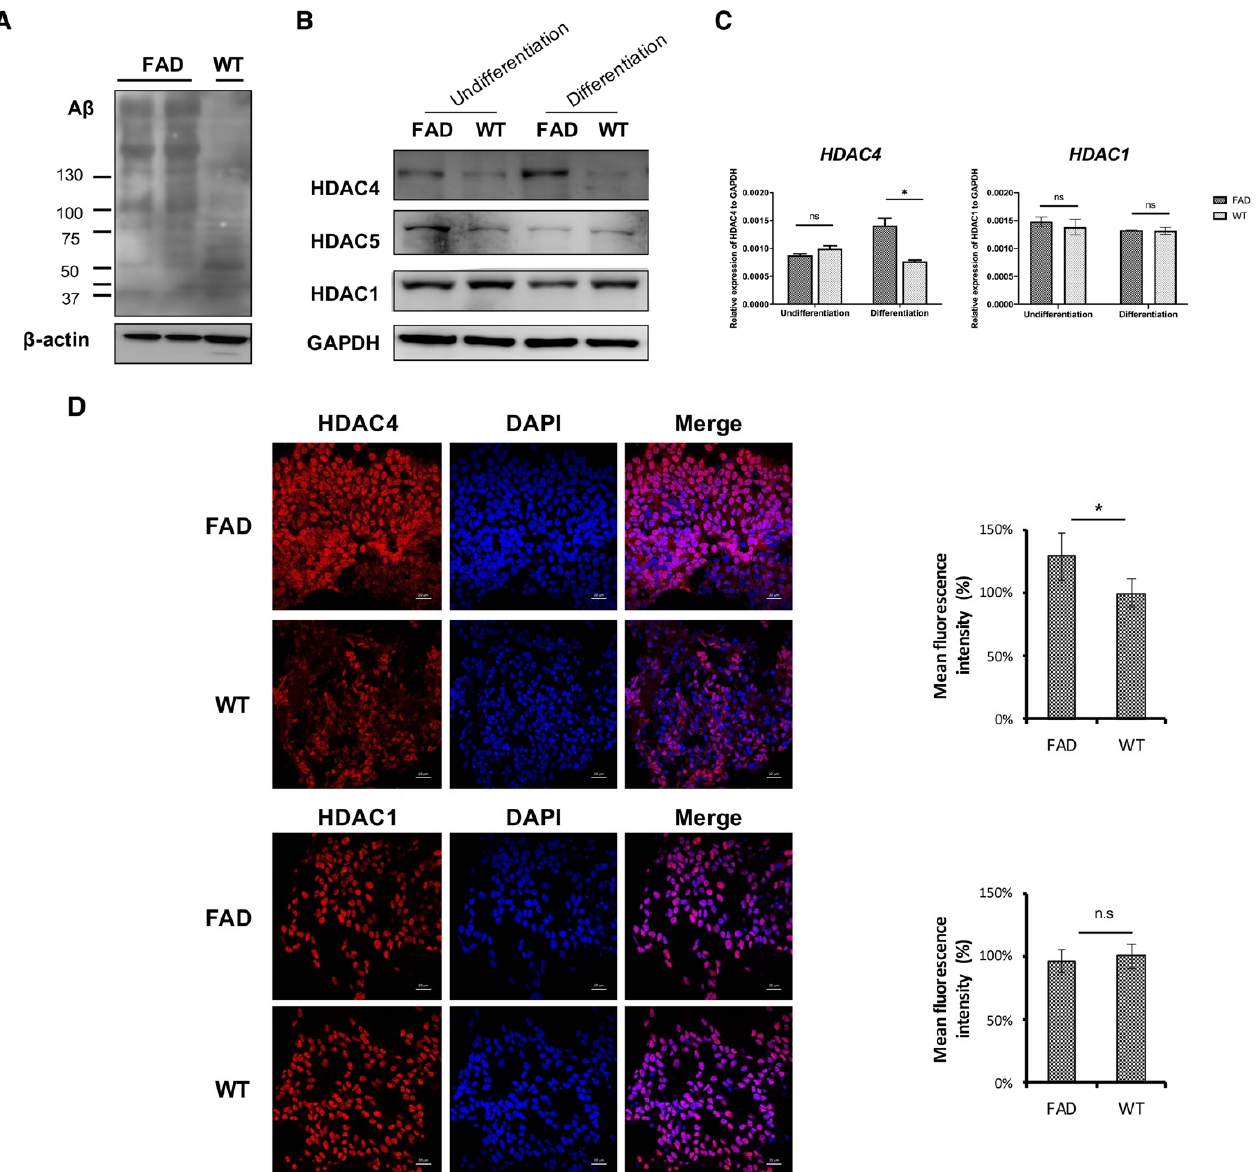
Figure 2. The level of HDAC4 was increased in the FAD human neural cell model. ( A ) A β expression was confirmed by western blot. Internal control: β -actin. ( B ) Representative Western blot of HDAC4, HDAC5, and HDAC1 on day 7 after the induction of differentiation. Internal control: GAPDH. ( C ) Quantitative RT-PCR analysis of HDAC4 (left panel) and HDAC1 (right panel) in differentiated FAD cells. Gene expression levels were normalized against GAPDH levels in each sample. Data are mean ± SD. * p < 0.05, and n.s., nonsignificant by Student’s t test. * p = 0.0117, FAD versus WT. ( D ) Representative confocal micrographs of FAD differentiated cells immunolabeled with HDAC4. Right graphs depict the quantification of HDAC4 labeling intensity in differentiated FAD cells relative to WT control. * p = 0.0295, FAD versus WT by Student’s t test.